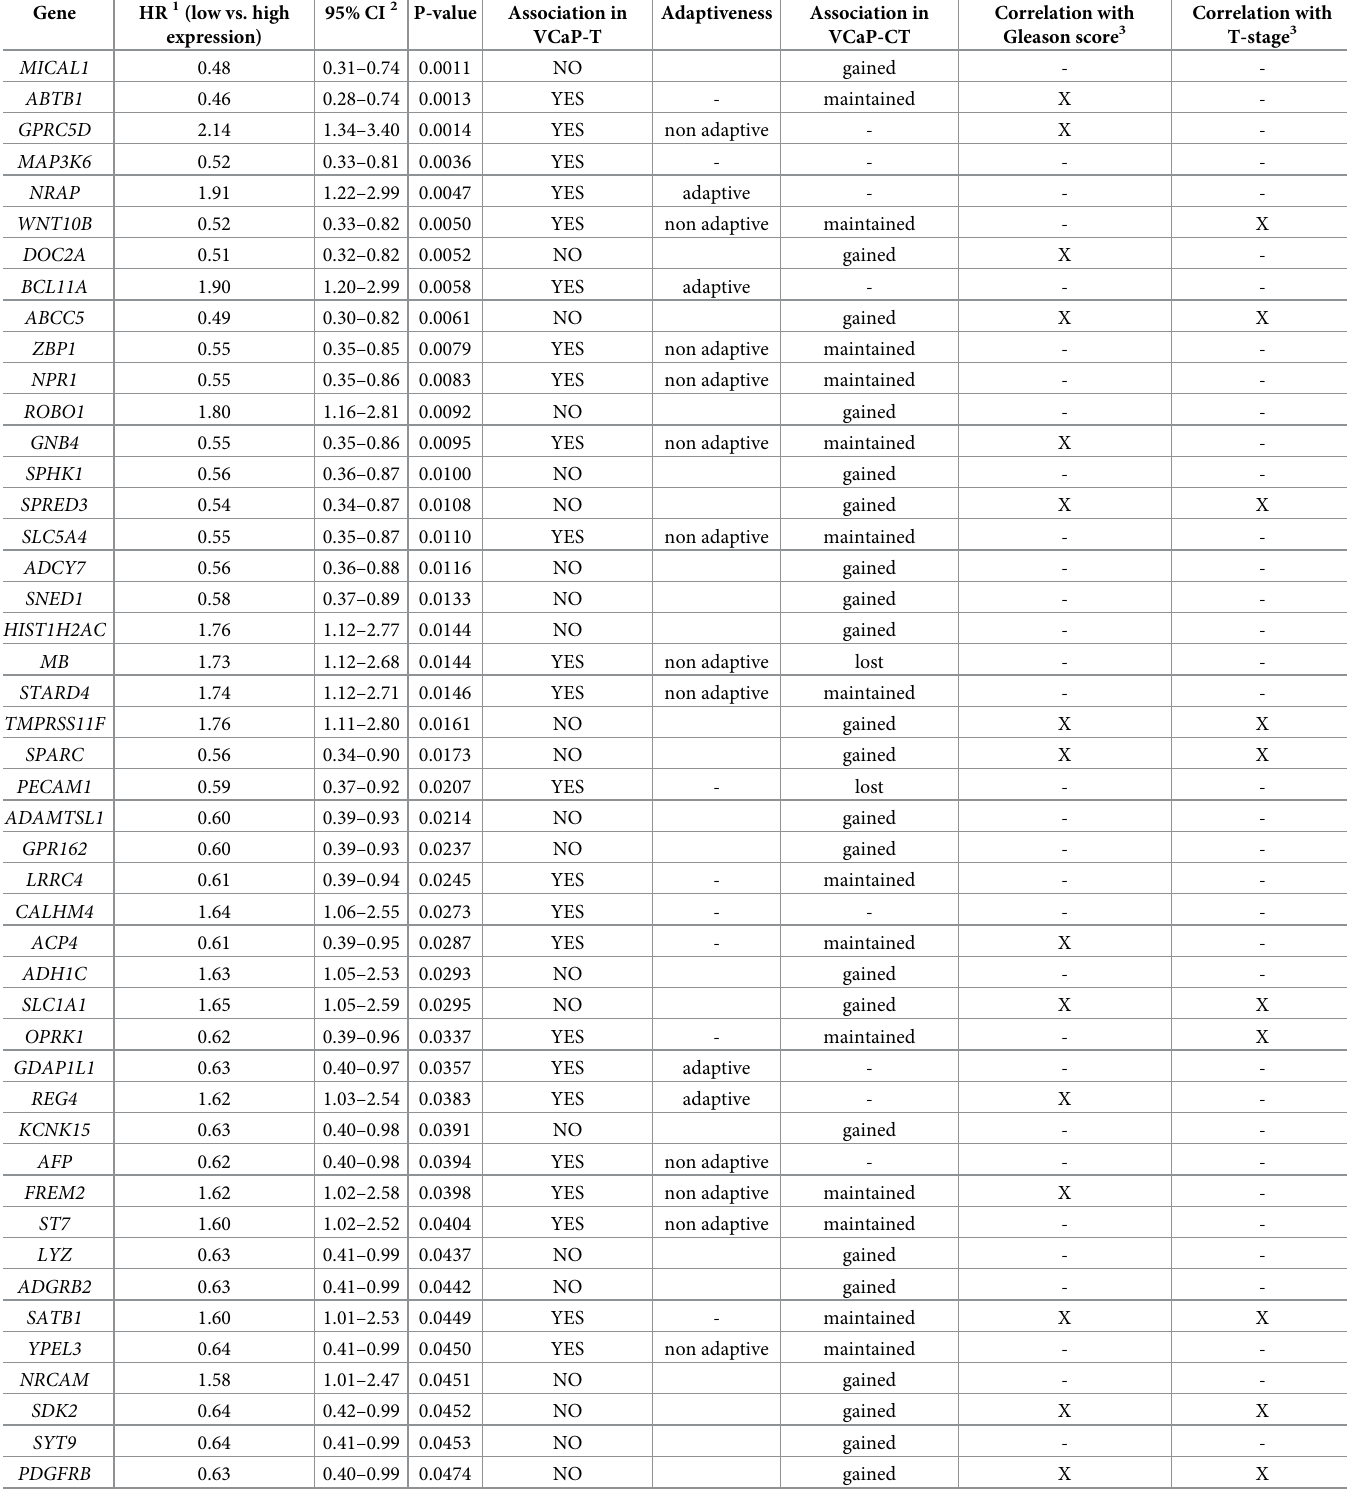
Table 1. Association between expression levels of androgen responsive genes and prostate cancer progression-free survival. Gene HR 1 (low vs.